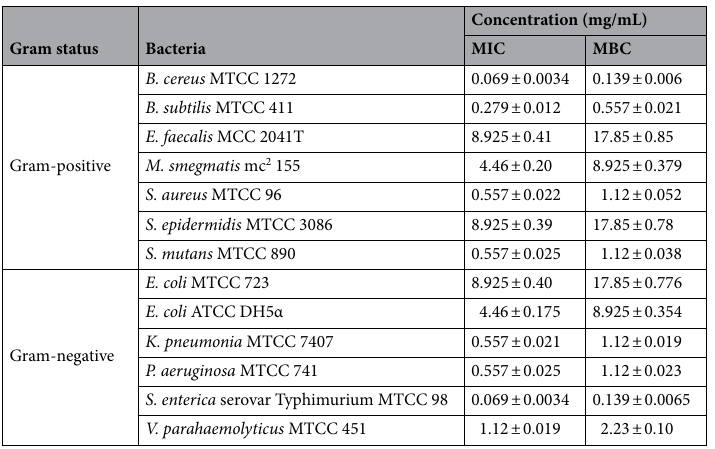
Table 4. MIC and MBC values of the 5-butyl-2-pyridine carboxylic acid against pathogenic bacteria. Here, the values are the average of triplicate trials ± SE, while the ’MIC’ and ’MBC’ indicate the values of the active compound that caused significant loss of viability of the